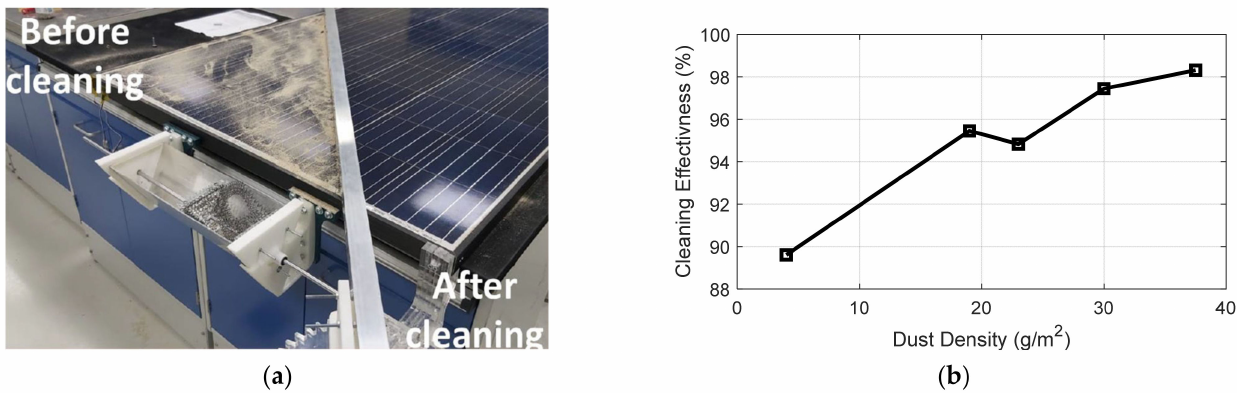
Figure 19. The cleaning effectiveness of the presented SMA-driven cleaning method under differ- ent dust densities, where ( a ) the actual performance of the self-cleaning operations, and ( b ) the quantitative outcome of the cleaning effectiveness percentages versus dust